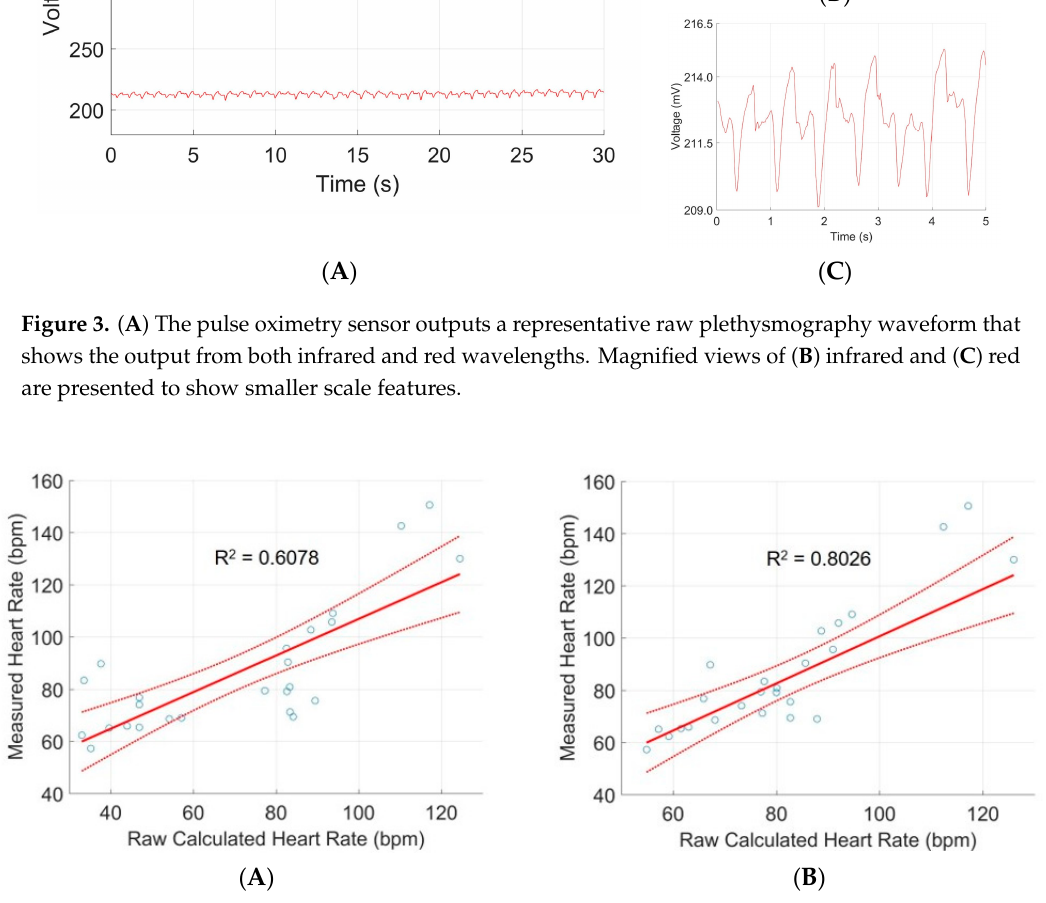
Figure 4. Linear regression models to compare the mean commercial sensor pulse oximetry rate to mean heart rate calculated using ( A ) red waveforms and ( B ) infrared waveforms from multiple test subjects. 95% confidence intervals are plotted for each regression model.